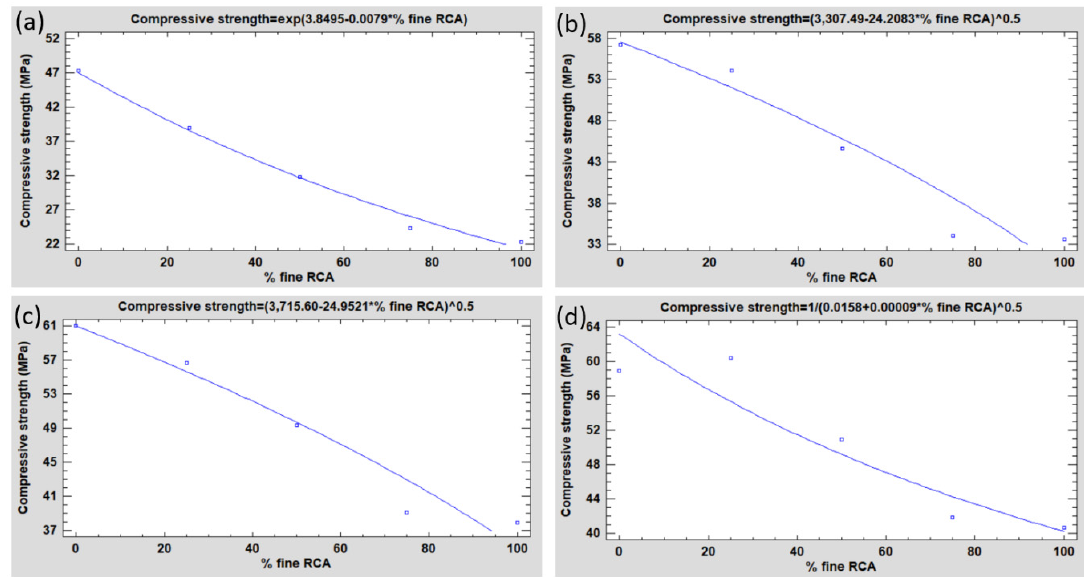
Figure 7. Best-fit models of compressive strength as a fine RCA percentage function: ( a ) 1 day; ( b ) 7 days; ( c ) 28 days; ( d ) 90 days.